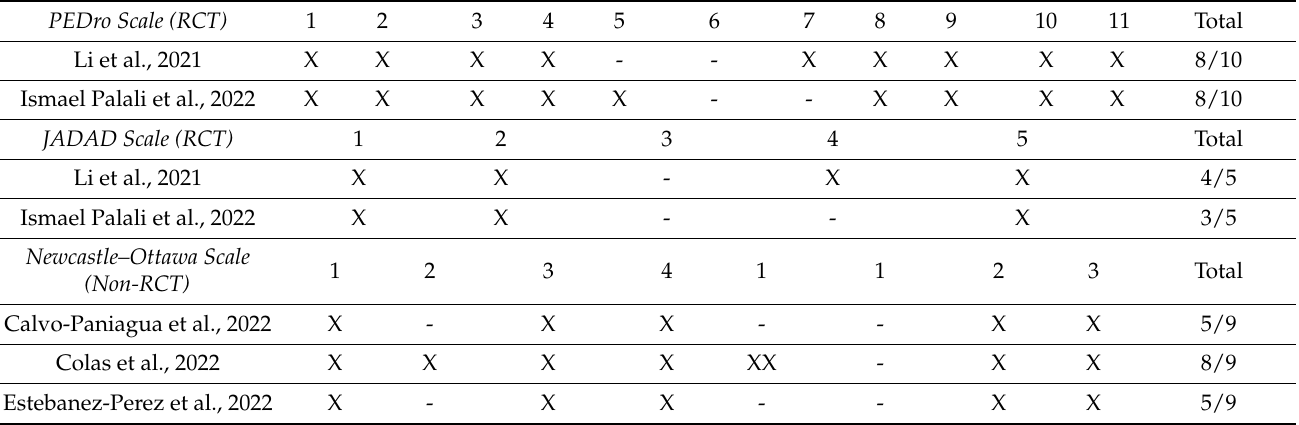
Table 3. Individual Quality